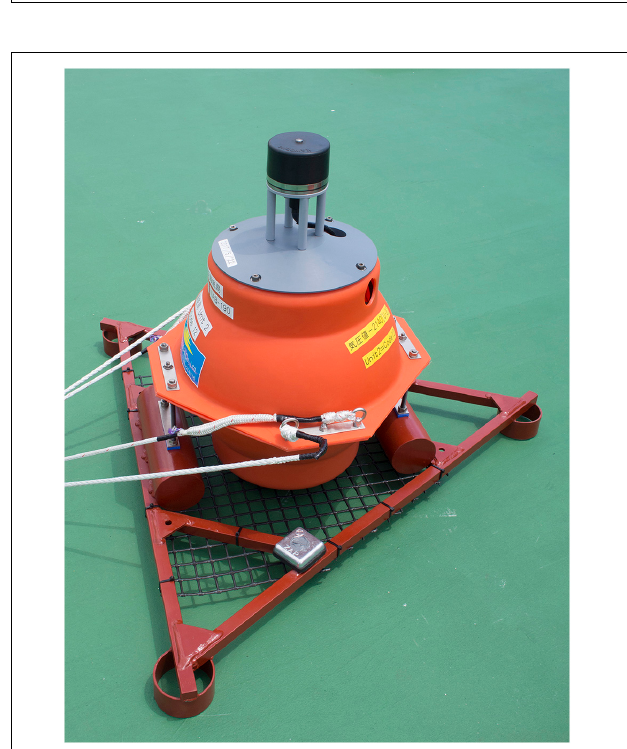
was stored in a data storage server. The ground base station was in the inland town of Niyodogawa, Kochi Prefecture ( Figure 2 ), which is 30 km from the southern coast of Japan and is